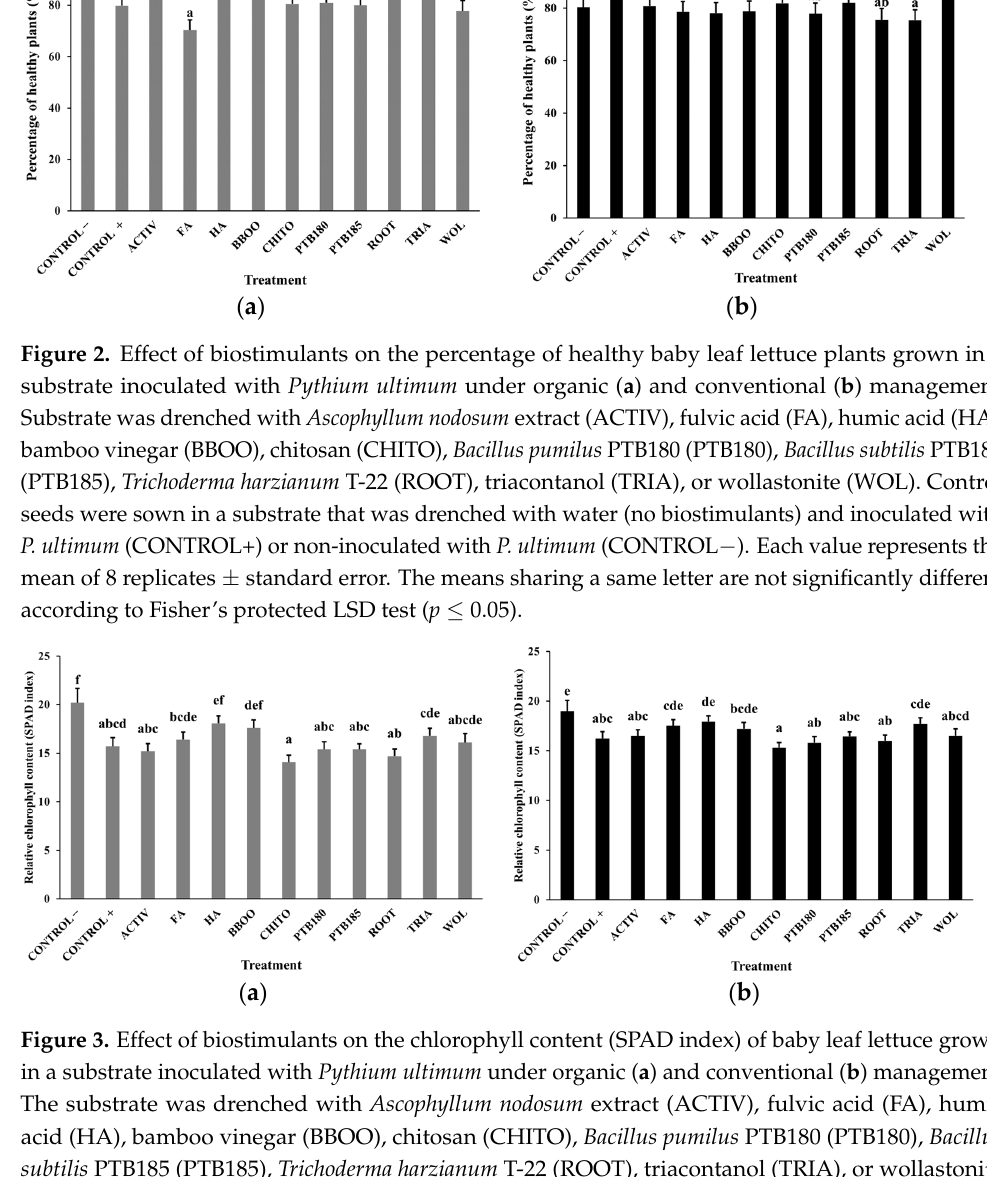
( b ) Figure 4. Effect of biostimulants on the shoot dry biomass of baby leaf lettuce plants grown in a substrate inoculated with Pythium ultimum under organic ( a ) and conventional ( b ) management. The substrate was drenched with Ascophyllum nodosum extract (ACTIV), fulvic acid (FA), humic acid (HA), bamboo vinegar (BBOO), chitosan (CHITO), Bacillus pumilus PTB180 (PTB180), Bacillus subtilis PTB185 (PTB185), Trichoderma harzianum T ‐ 22 (ROOT), triacontanol (TRIA), or wollastonite (WOL). Control seeds were sown in a substrate that was drenched with water (no biostimulants) and inoculated with P. ultimum (CONTROL +) or non ‐ inoculated with P. ultimum (CONTROL − ). Each value represents the mean of 8 replicates ± standard error. The means sharing a same letter are not significantly different according to Fisher’s protected LSD test ( p ≤ 0.05). 3.2. Effect of Biostimulants on Baby Leaf Lettuce Grown under Salinity Stress Under organic management, Trichoderma harzianum T ‐ 22 seed treatment (+1.41 to 2.59 times), triacontanol (+1.37 to 4.40 times), and wollastonite (+1.41 to 4.17 times)